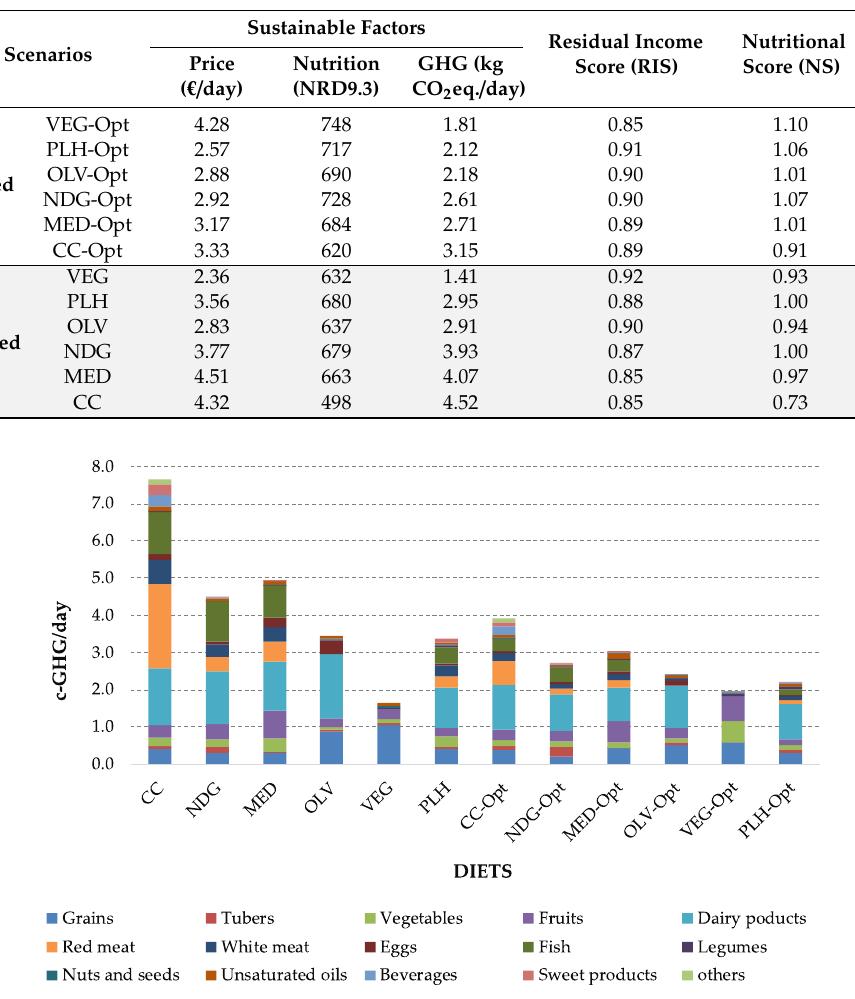
Figure 6. Daily gross food intake (g/day) of different food categories for all optimized diets. Table 5. Sustainable factors and scores to estimate the corrected GHG emissions (c-GHG).